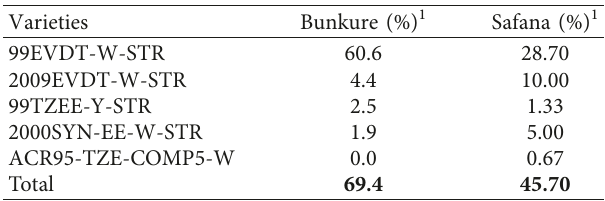
Table 7: Adoption of improved maize varieties in Bunkure and Safana LGAs,